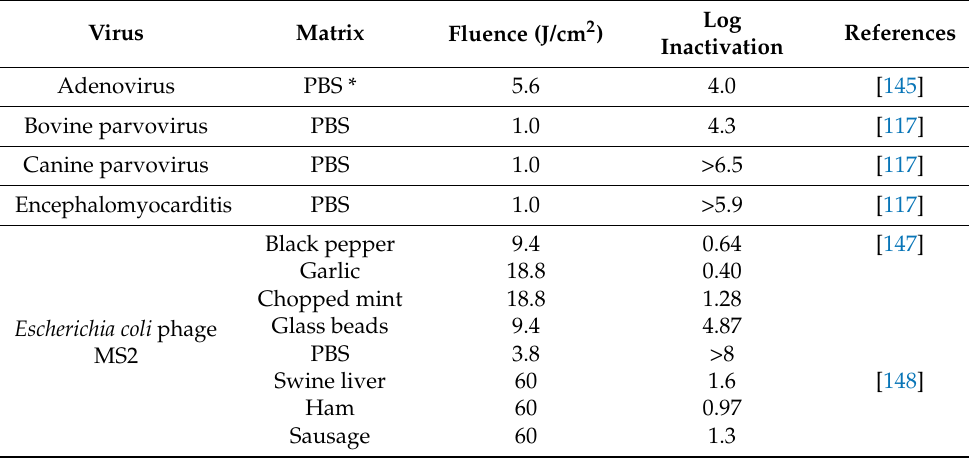
Table 1. Inactivation of viruses by pulsed